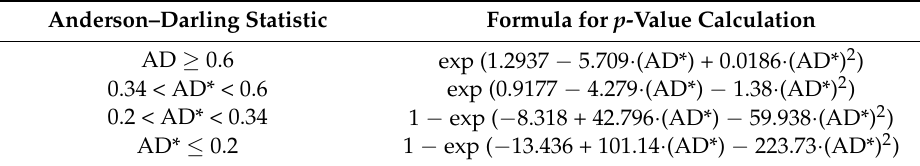
Table 3. Anderson–Darling for small sizes: p -values